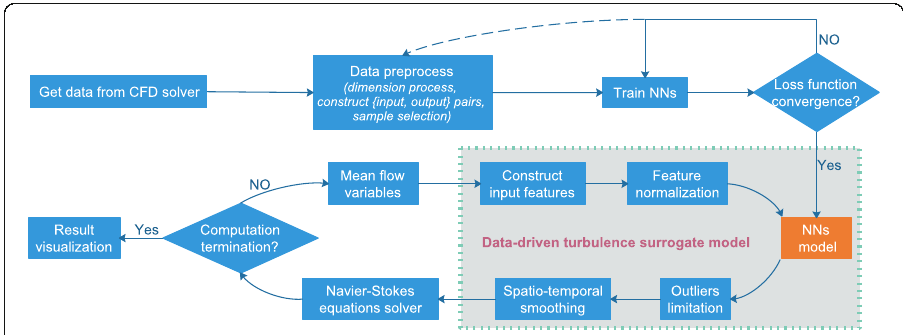
Fig. 1 Flow chart for building the turbulence surrogate